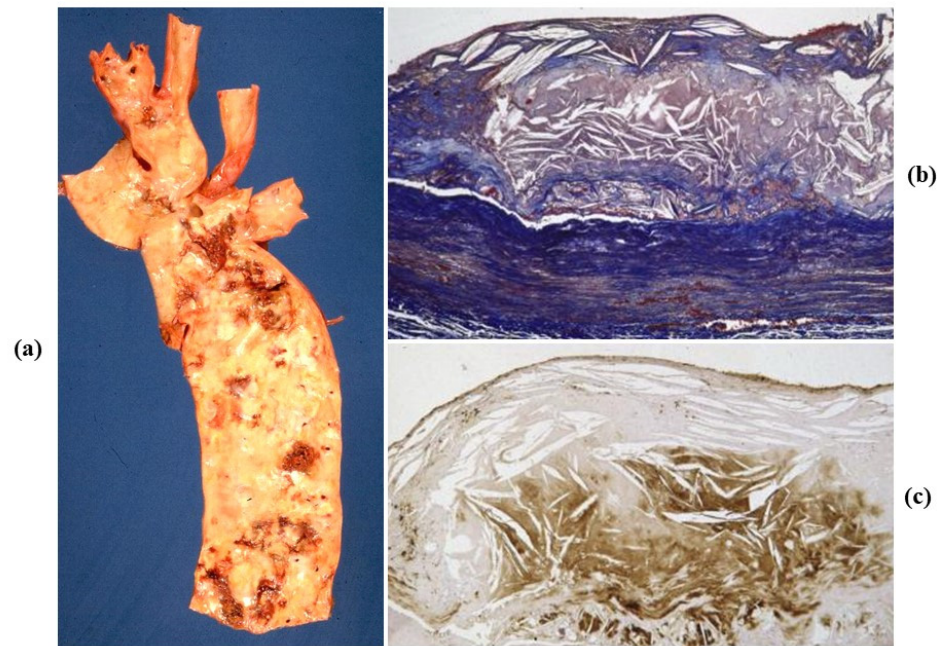
Figure 12. ( a ) Atherothrombosis of the thoracic aorta, gross view. ( b , c ) Histology of atherosclerotic plaque. (Weigert Van Gieson and C-68 immuno stains).